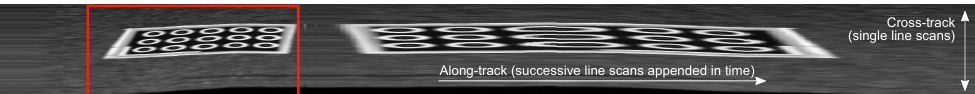
Figure 6. Example grey scale image obtained by appending successive line scans from Ladybird (without pose compensation). A single view of all points on the calibration pattern is referred to as an observation in this paper, including concurrent navigation system data. The red box indicates one such observation, shown as a more detailed close-up view in Figure 7. The two views of the calibration pattern shown in this figure were obtained by driving the platform forward, producing the first view, and then backwards, giving the second view, which is therefore a mirrored version of the first. The second view appears more stretched because it was scanned more slowly, generating more line scans, given the same fixed frame rate. Note that the observations shown in Figure 5a only include one observation from each forward-reverse pair, because they provide almost the same information (i.e., similar navigation system solutions).